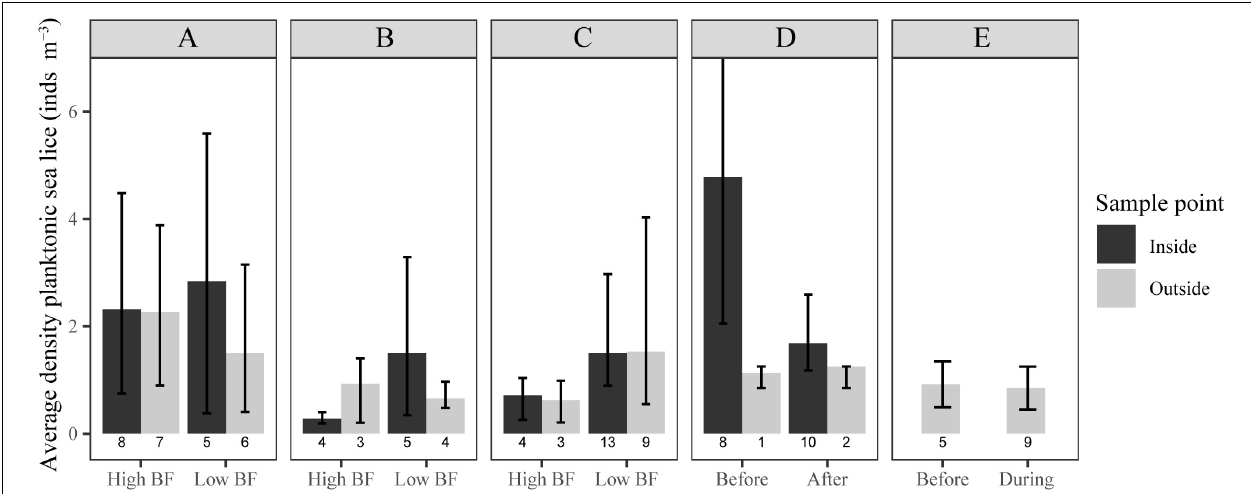
FIGURE 2 | Average density of planktonic sea lice (individuals m - 3 , is based on only those replicates containing at least one sea louse) for samples taken from the inside (black bar) and outside (gray bar). Divided for experiment and site [NoskirtA (A) , NoskirtB (B) , Liceskirt7 (C) , Liceskirt10 (D) , NoskirtC (E) ], and biofouling category [Hight biofouling (BF): biofouling ≥ 30%, Low BF: biofouling < 30%, Lice skirt ∼ High BF: site has lice skirt and it is assumed to act as High BF] Total number of replicate net pens in each category is shown under the bars. Error bars show Bias-corrected and accelerated bootstrap (2000) 95% confidence intervals for (A–D) , and standard deviation for (E) . TABLE 2 | Total number of nauplii and copepodites of sea lice found in plankton samples (vertical plankton tows) from the five sites.